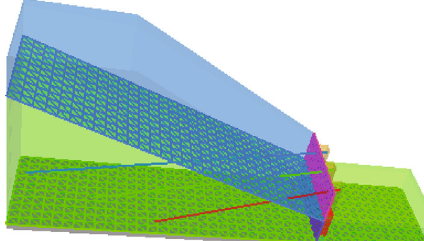
Figure 9: Three-dimensional model of the anchor